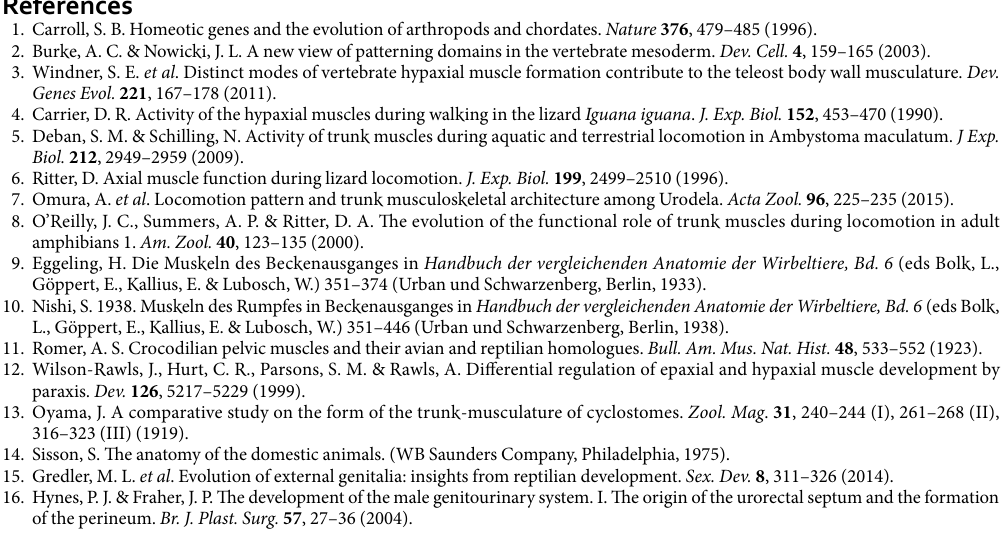
Table 1. Sample used in our